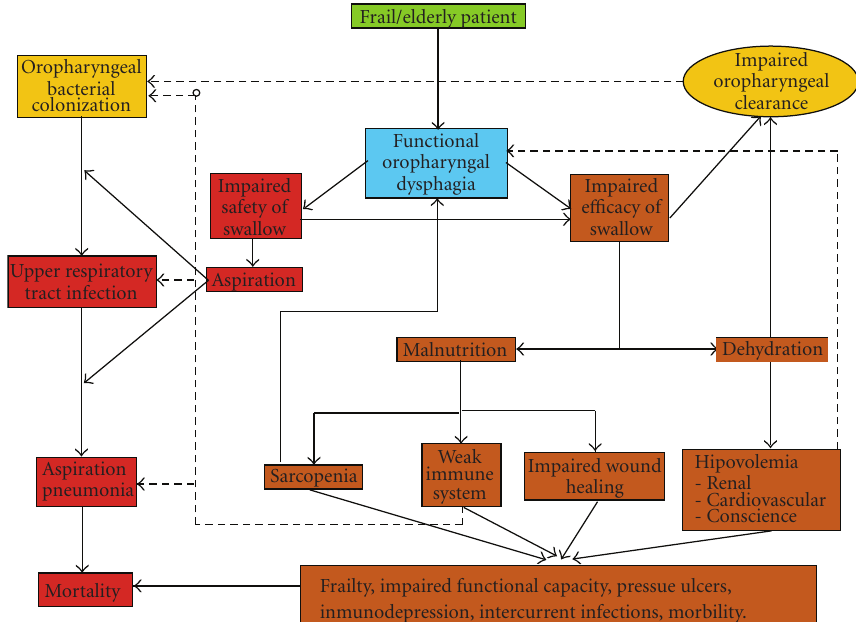
Figure 5: Pathophysiology of nutritional and respiratory complications associated to oropharyngeal dysphagia in elderly